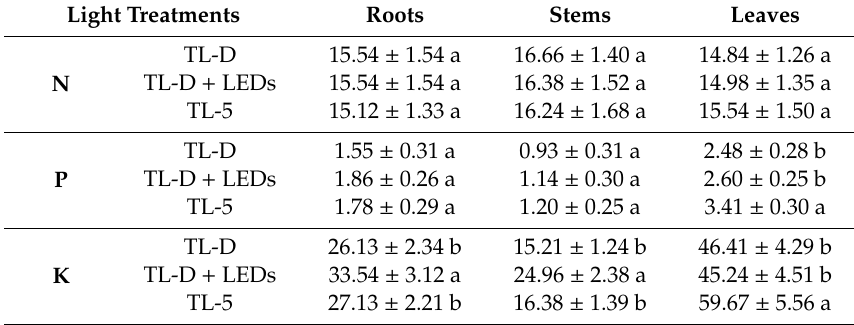
Table 2. Mineral nutrient composition (expressed in mg g − 1 DW) in roots, stems and leaves of F. verschaffeltii treated with different light treatments at the end of the experiment (8 weeks). Values with the same letters are not significantly different at p < 0.05 (ANOVA and LSD test). ns: not significant. Data are the means ± standard deviation of five plants per treatment.